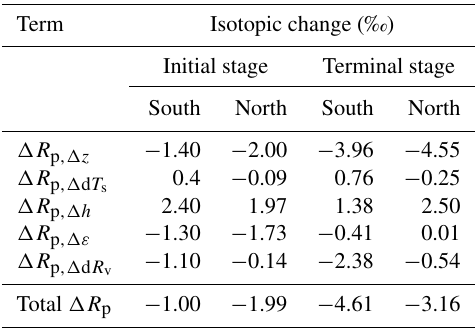
Table 2. INT-LOW and MOD-INT sensitivity of the decomposition terms (in ‰) to the changes of R v0 , T 0 , q 0 , of 1‰, 1K and 10% respectively.